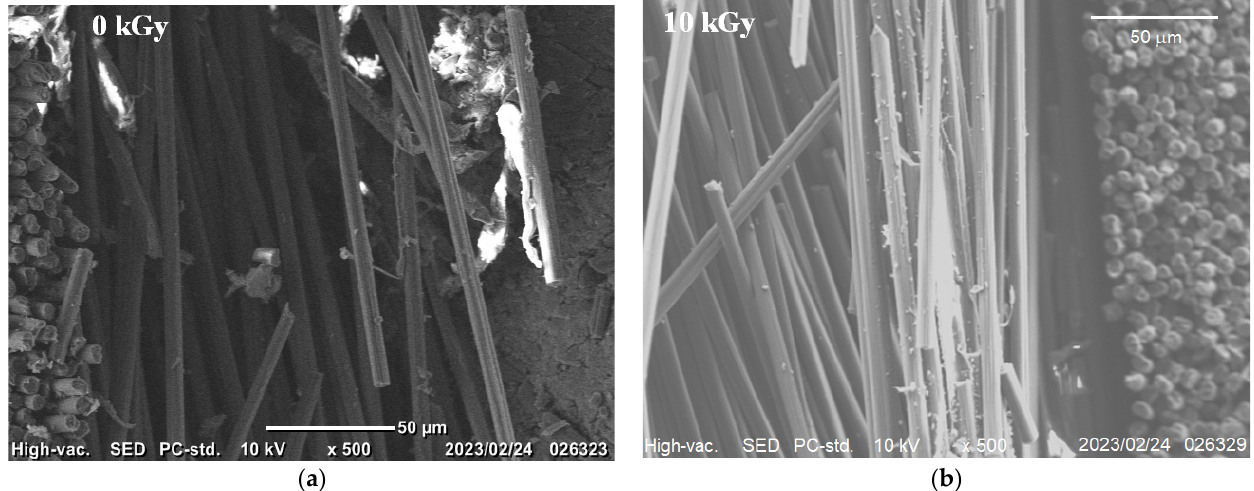
Figure 11. SEM photomicrographs of untreated ( 0 kGy ) ( a ) and 10 kGy ( b ) [PPS] 4 [CF] 3 samples, respectively.